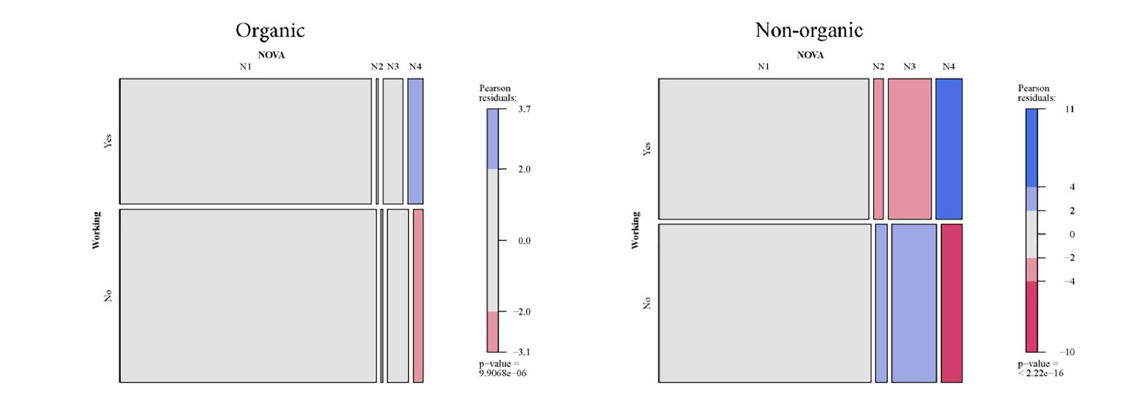
FIGURE2 Relationship between employment situation of the person responsible for the household and NOVA: Organic vs. non-organic food purchases.